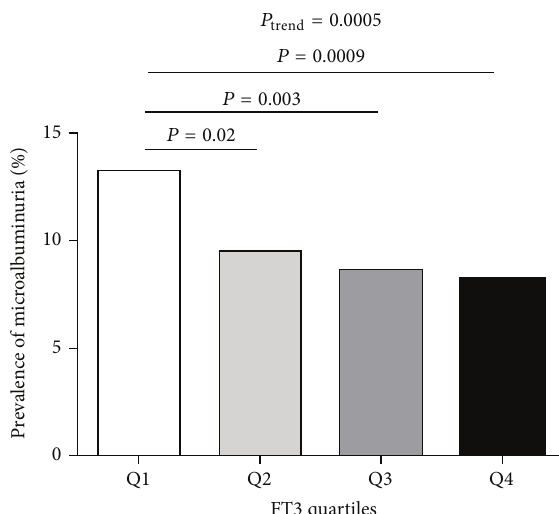
Figure1:PrevalenceofmicroalbuminuriaindifferentFT3quartiles: quartile 1 (Q1, 𝑛 = 111 ), ≤ 4.28 pmol/L; quartile 2 (Q2, 𝑛 = 80 ), 4.29– 4.60 pmol/L; quartile 3 (Q3, 𝑛 = 73 ), 4.61–4.93 pmol/L; quartile 4 (Q4, 𝑛 = 67 ), >